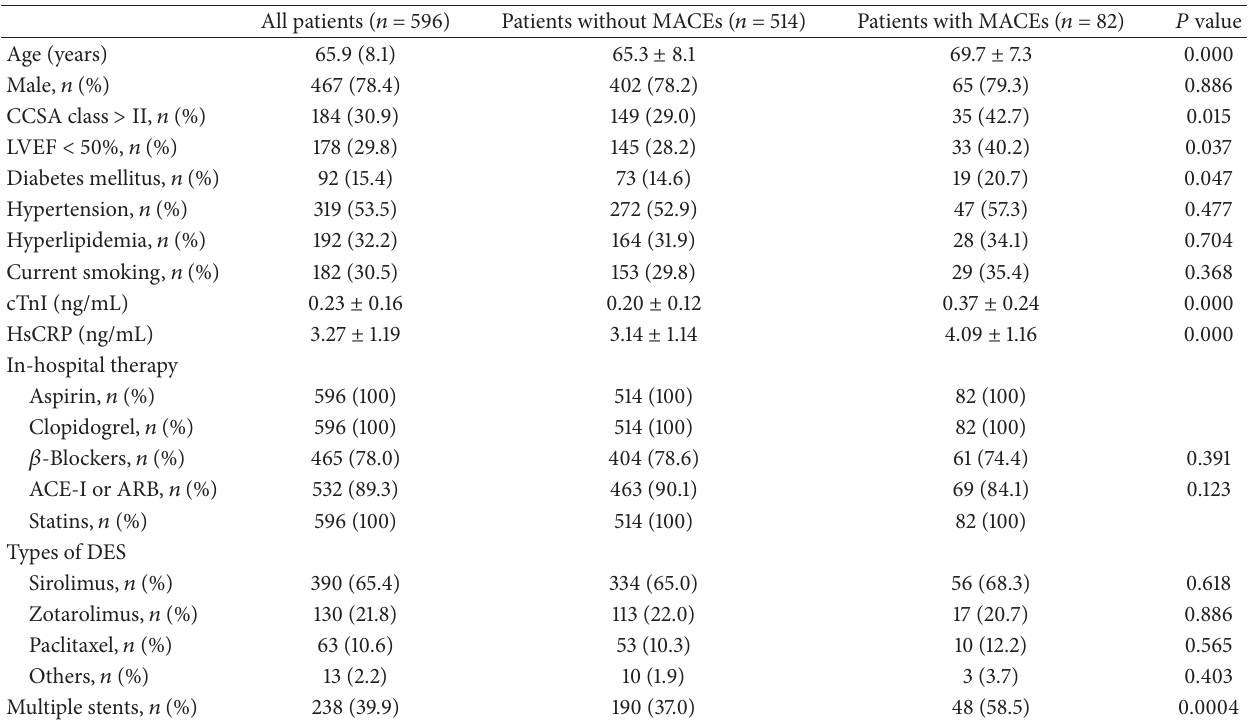
Table 1: Clinical characteristics of patients with and without